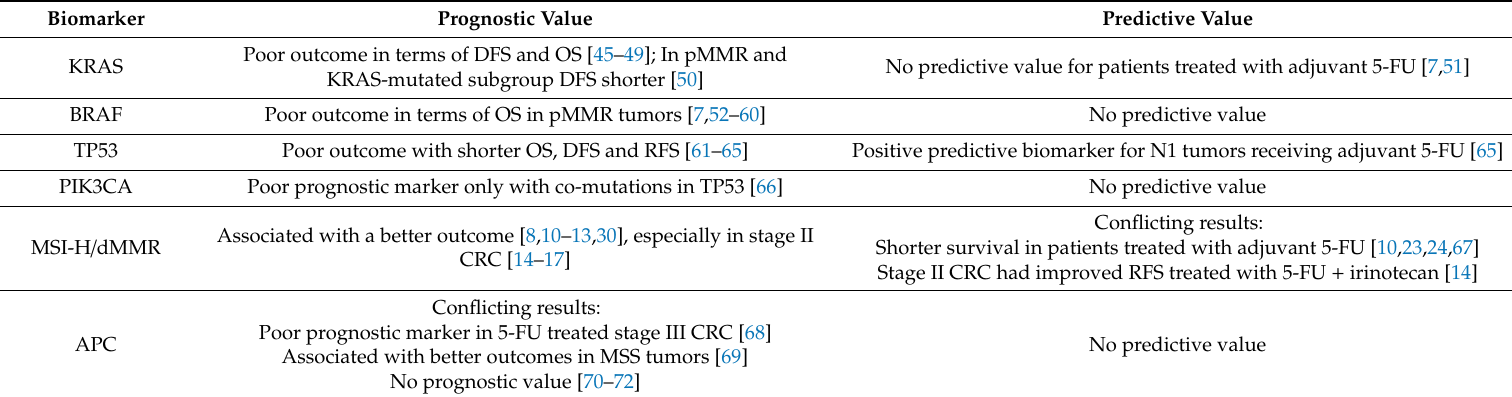
Table 2. Prognostic and Predictive Molecular Biomarkers Analyzed in Nonmetastatic Colorectal